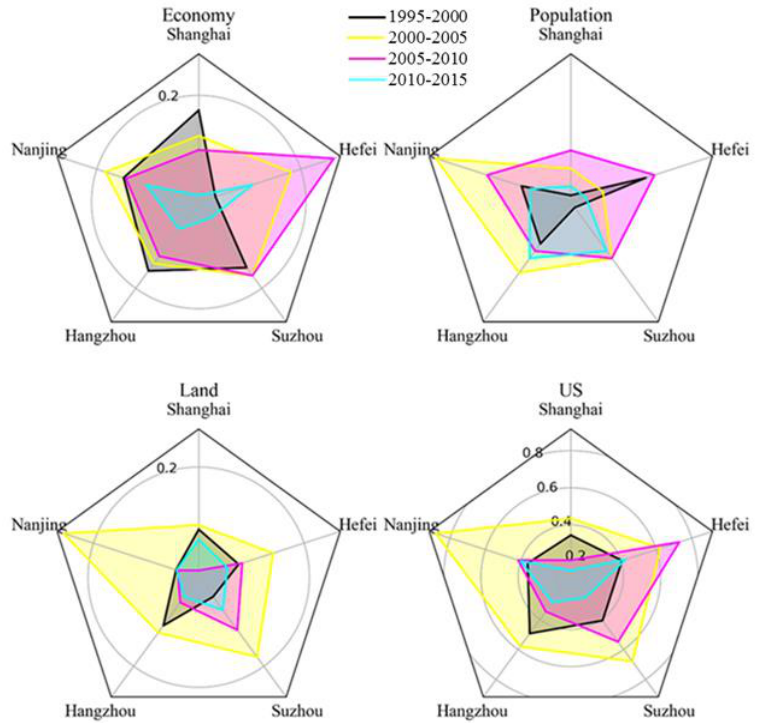
Figure 10. Radar map of economic, population, built-up area growth rate, and urbanization speed (US) values of the five major cities in the YRD region.